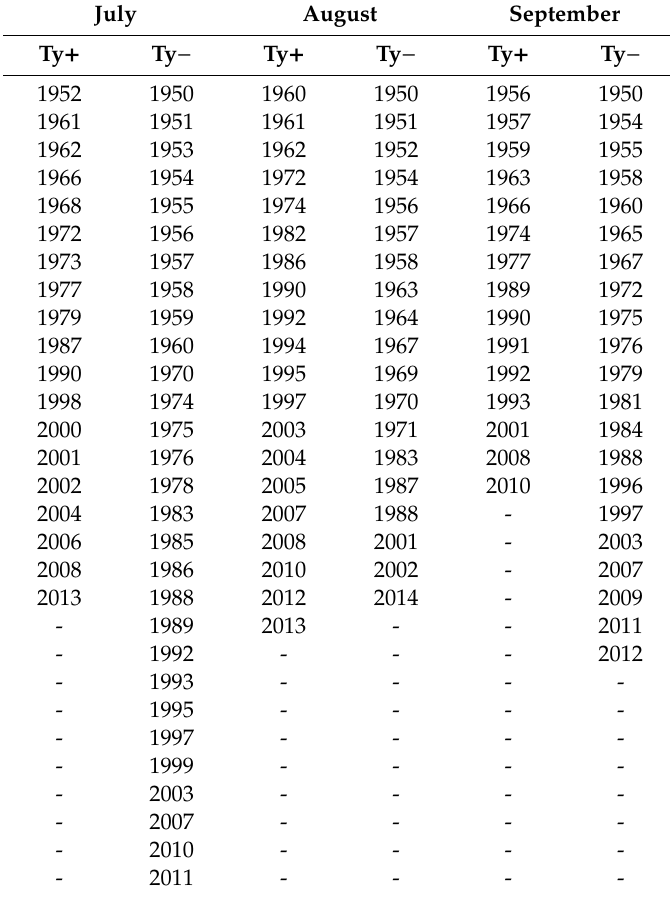
Table 1. Year list for the Ty + category and Ty − category in each investigated